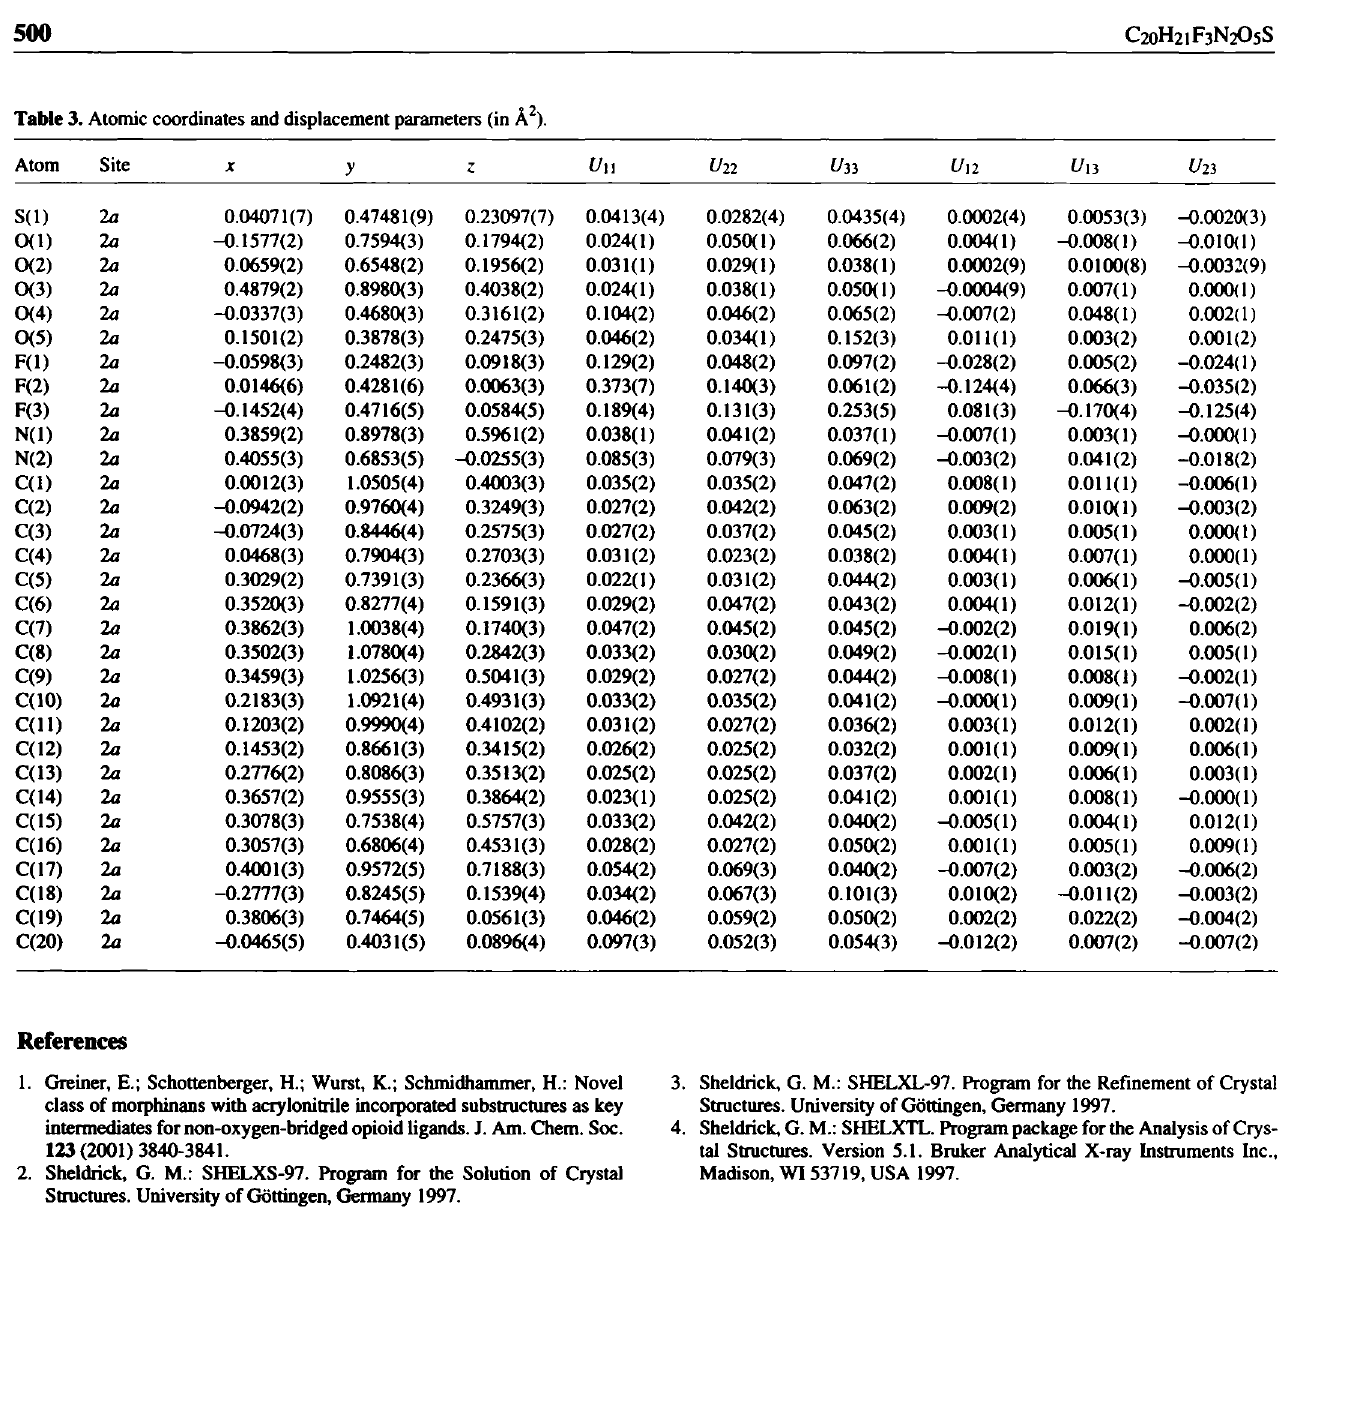
Table 3. Atomic coordinates and displacement parameters (in À 2